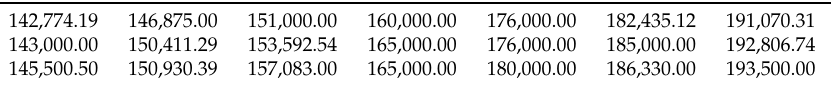
Table 7. Unobserved costs of legal events (below